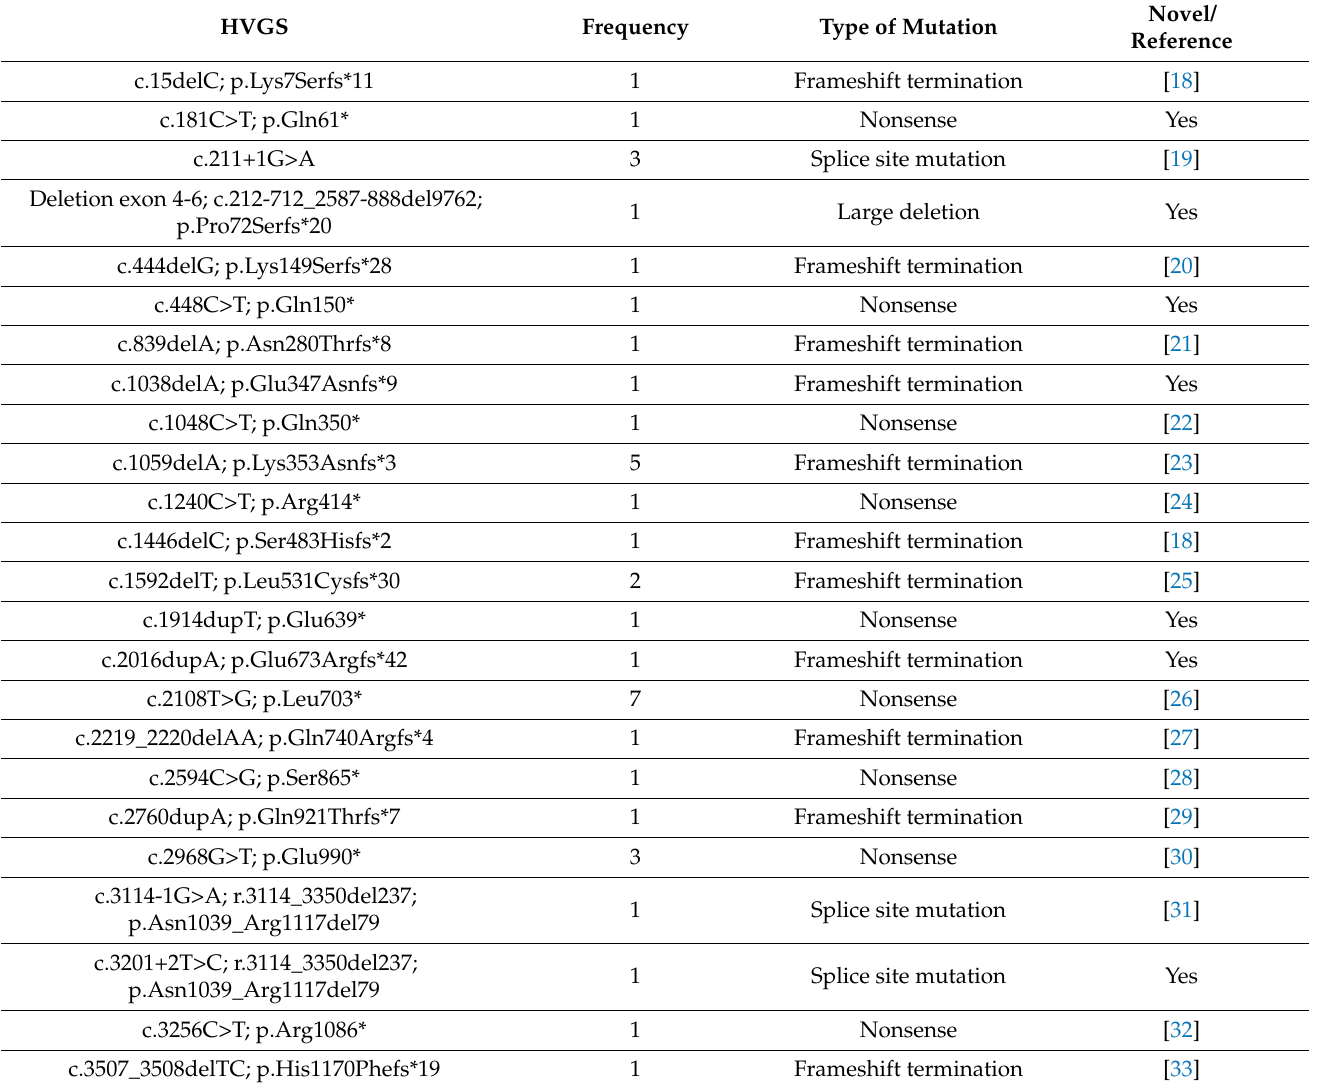
Table 4. Germline heterozygous variants identified in PALB2